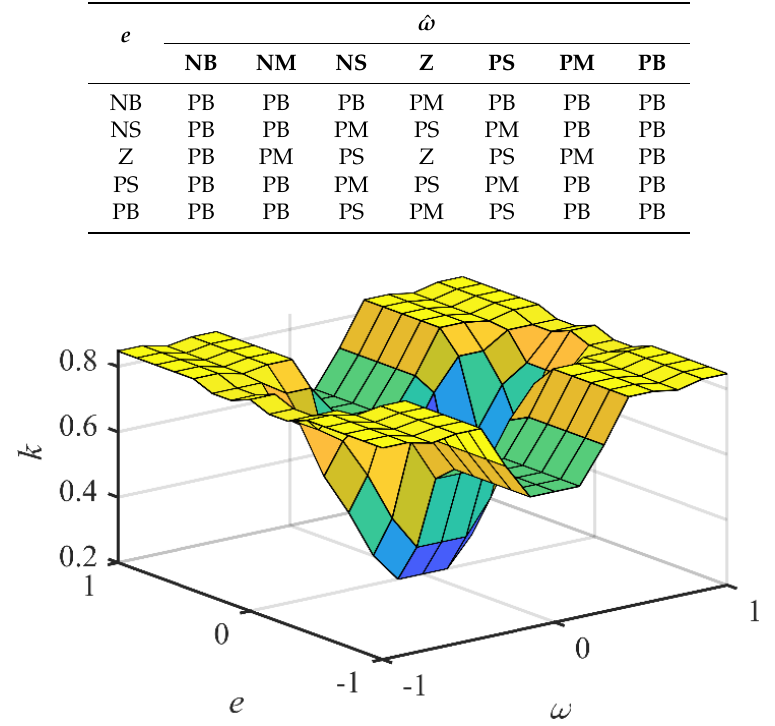
Figure 8. Rule surface for output k